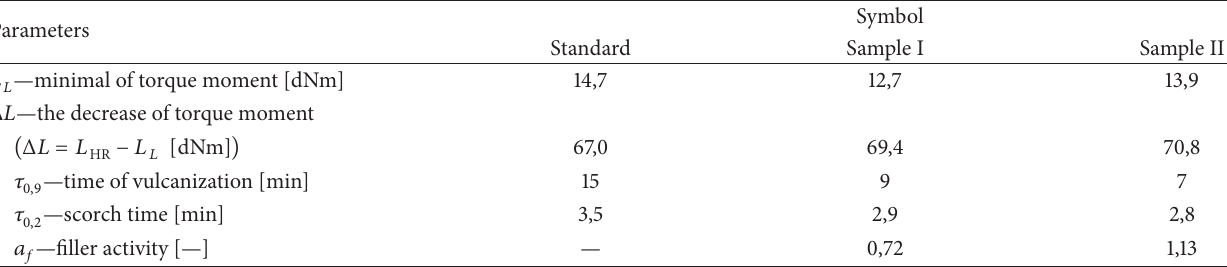
Table 3: The influence of keratin on the rheometric properties of NBR mixes.